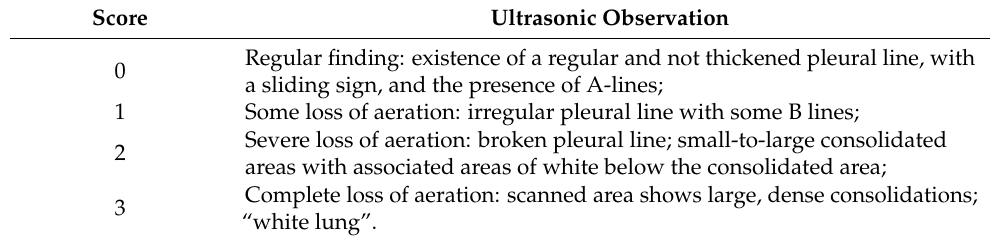
Table 1. Lung ultrasound point scoring system. Score Ultrasonic Observation Regular finding: existence of a regular and not thickened pleural line, with 0 a sliding sign, and the presence of A-lines; 1 Some loss of aeration: irregular pleural line with some B lines; Severe loss of aeration: broken pleural line; small-to-large consolidated areas with associated areas of white below the consolidated area; Complete loss of aeration: scanned area shows large, dense consolidations; “white